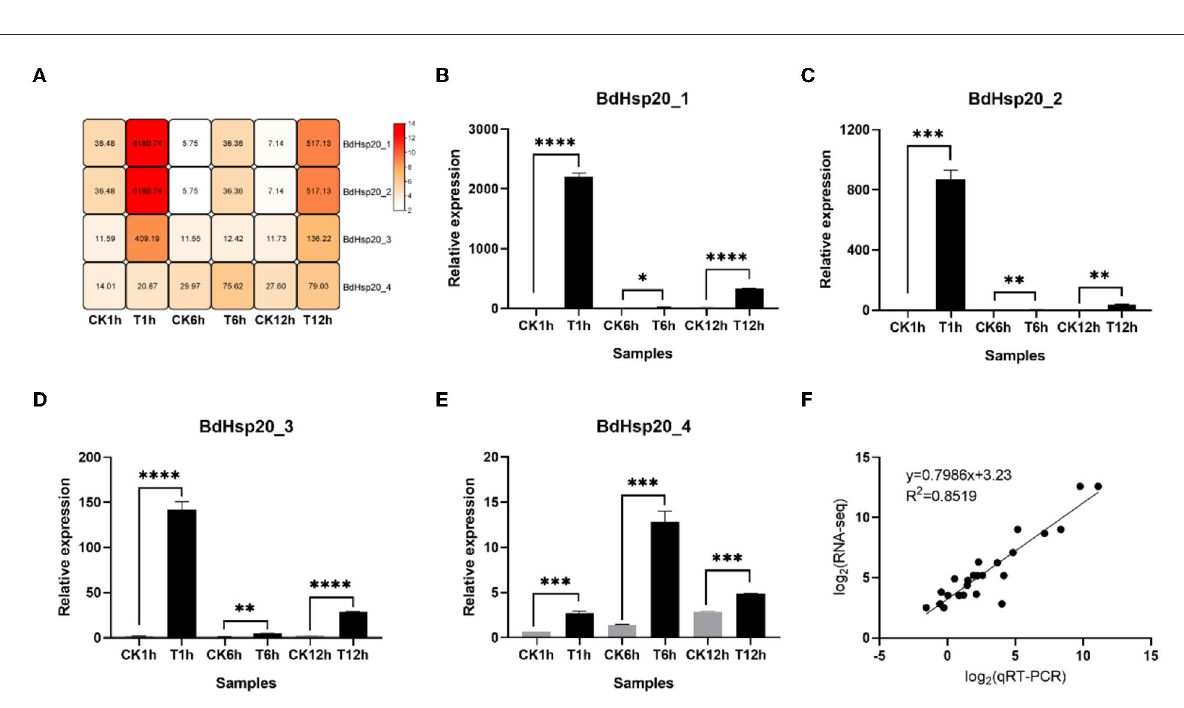
genes in the fungi was much less than that in plant species such as apples (Yao et al., 2020), tomatoes (42) (Yu et al., 2016), potatoes (42) (Zhao et al., 2018), pumpkin (33) (Hu et al., 2021), grape (48) (Ji et al., 2019), African bermudagrass